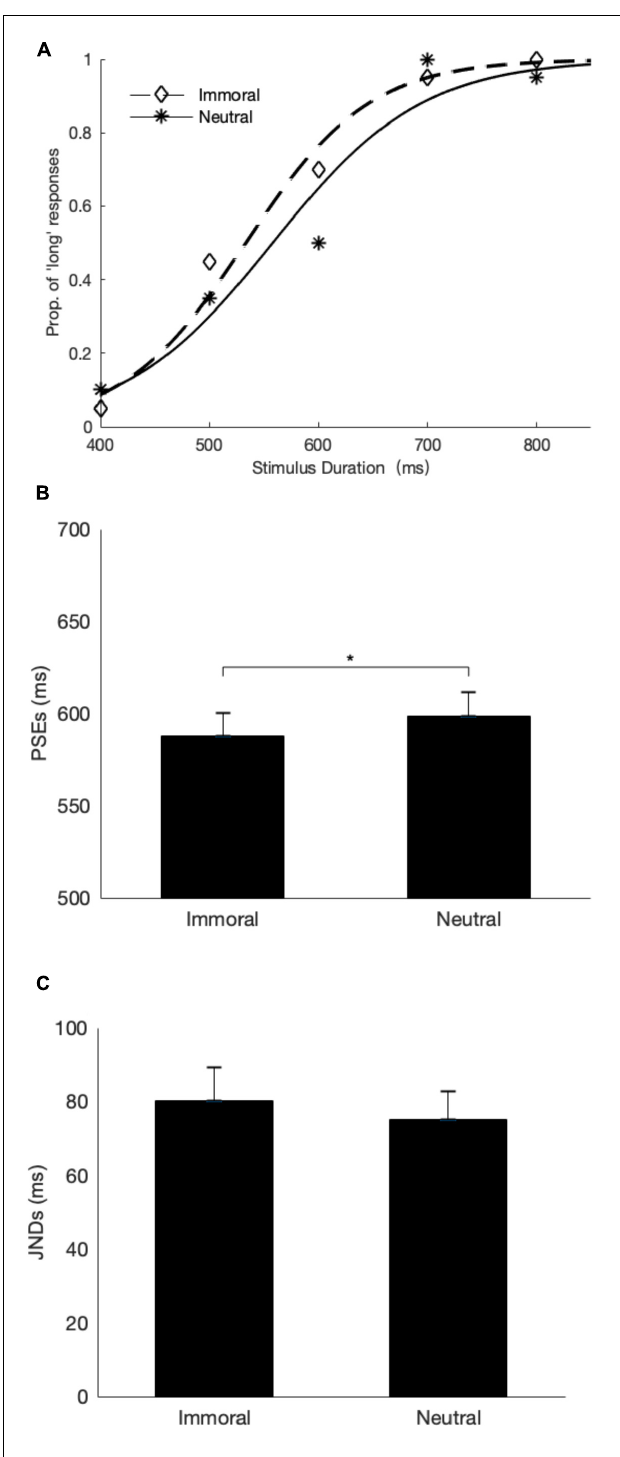
FIGURE 2 | Temporal judgment results of Experiment 1. (A) Mean proportions of “long” responses (diamonds: the immoral phrase, stars: the neutral phrase) for a representative subject are plotted as a function of the probe durations, together with fitted psychometric curves (dashed: the immoral phrase, solid: the neutral phrase). (B) The mean PSEs and their respective one-standard errors for the two conditions. (C) The mean JNDs and their corresponding one-standard errors for the two conditions. *denotes p ≤ 0.05.